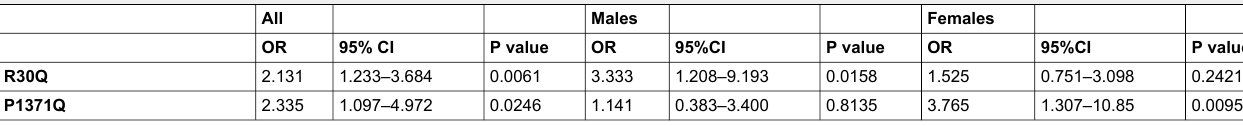
Table 2: Distribution of A allele of DLG5 SNPs P1371Q and R30Q in men and women.